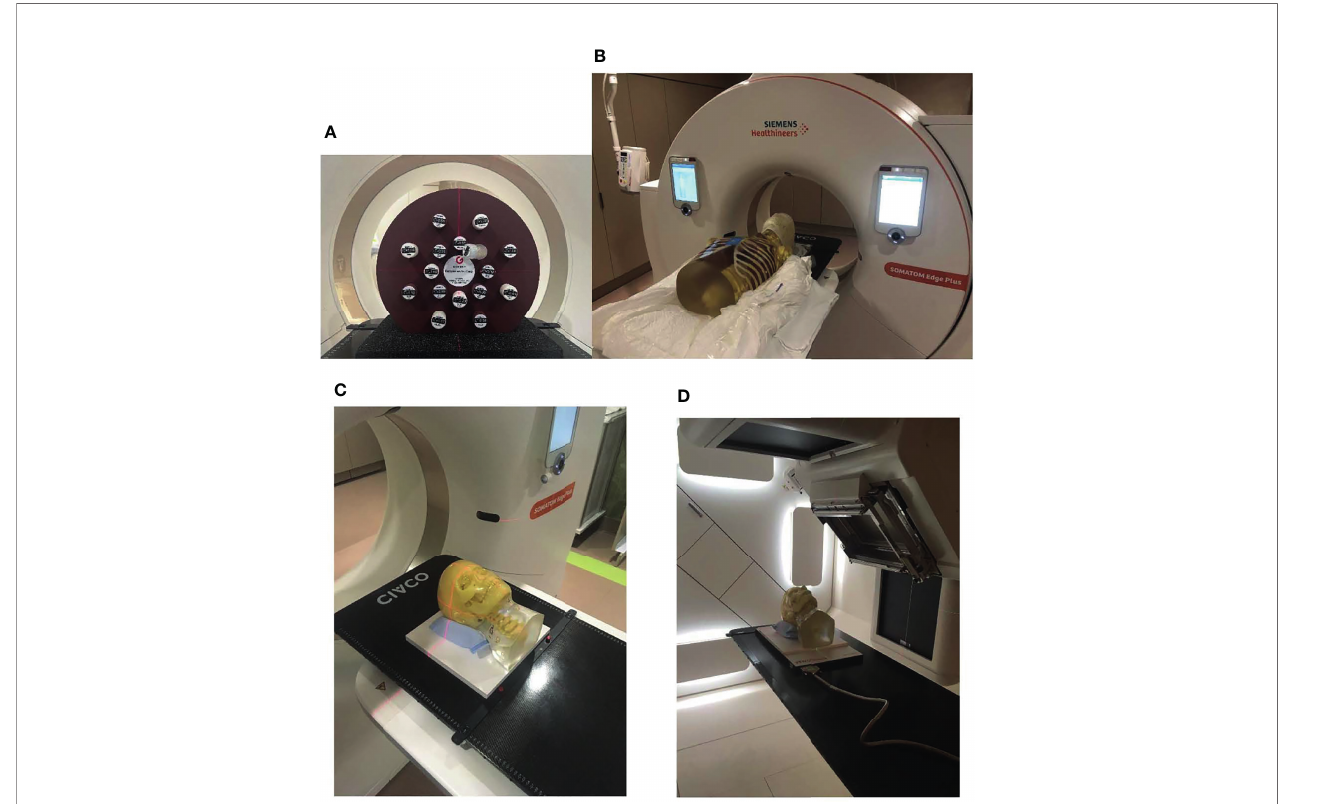
FIGURE 1 | Phantoms that were used in the study. (A) CT density phantom, (B) head and thorax phantoms put together on the simulator, (C) the head phantom on top of a solid water slab at the simulator, and (D) the head phantom on top of a solid water slab and a 2D ion chamber array at the treatment position ready for cone-beam CT (CBCT).